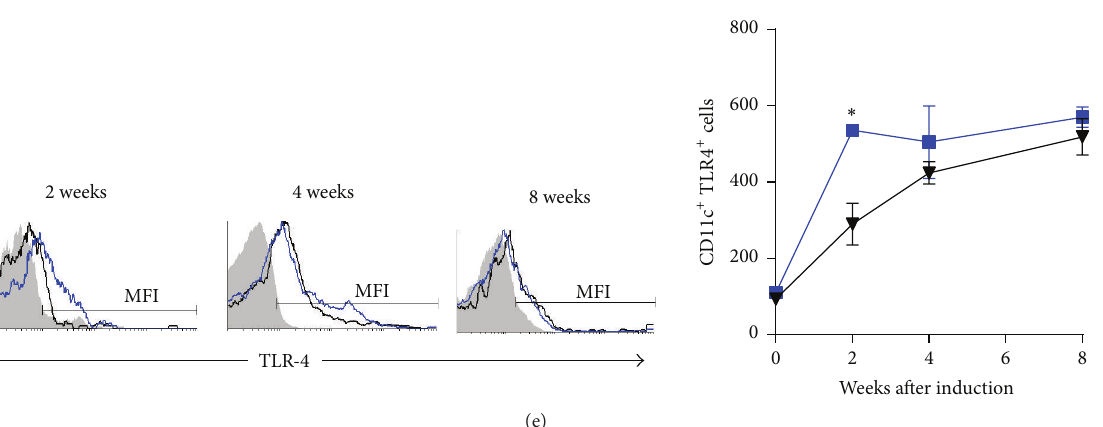
Figure 8: Mif promotes costimulatory molecules expression on pancreatic DC. The time course of costimulatory molecule: CD80 (a), CD86 (b), MHC-II (c), TLR-2 (d), and TLR-4 (e) expression on pancreatic CD11c DC. DC from pancreas of Wt and Mif − / − mice were harvested at 0, 2, 4, and 8 weeks after STZ administration and 1 × 10 7 cells/mL were processed by flow cytometric analysis as indicated in Section 2. Analyses of expression are shown in the right panels: WtSTZ ( ◼ ); Mif − / − STZ ( 󳶃 ). And representative histograms of expression based on fluorescence are shown in the left panels. Isotype controls are indicated in gray shadow, the black line represents expression by Mif − / − STZ cells, and the blue line shows expression by WtSTZ cells. The data are presented as the mean fluorescence intensities (MFI) from one representative experiment. Each experiment was repeated three times ( 𝑛 = 3 ) and individually analyzed. ∗ 𝑝 < 0.05 , ∗∗ 𝑝 < 0.01 , or ∗∗∗ 𝑝 < 0.001 , GraphPad Prism software 6.